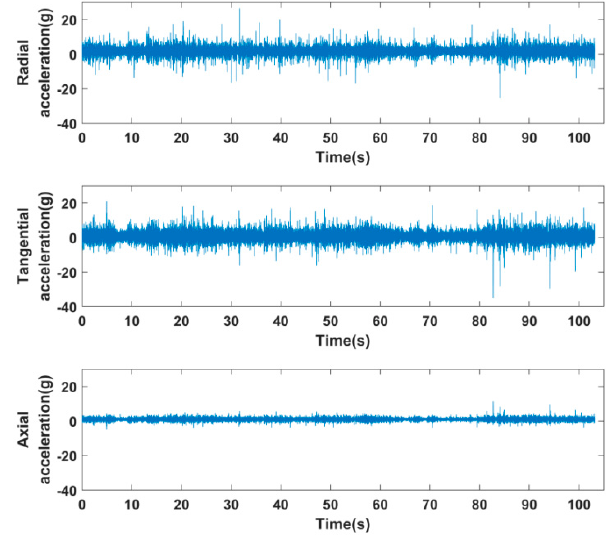
Figure 6. Timing chart of drilling signals intercepted from 4740 m to 4750 m.